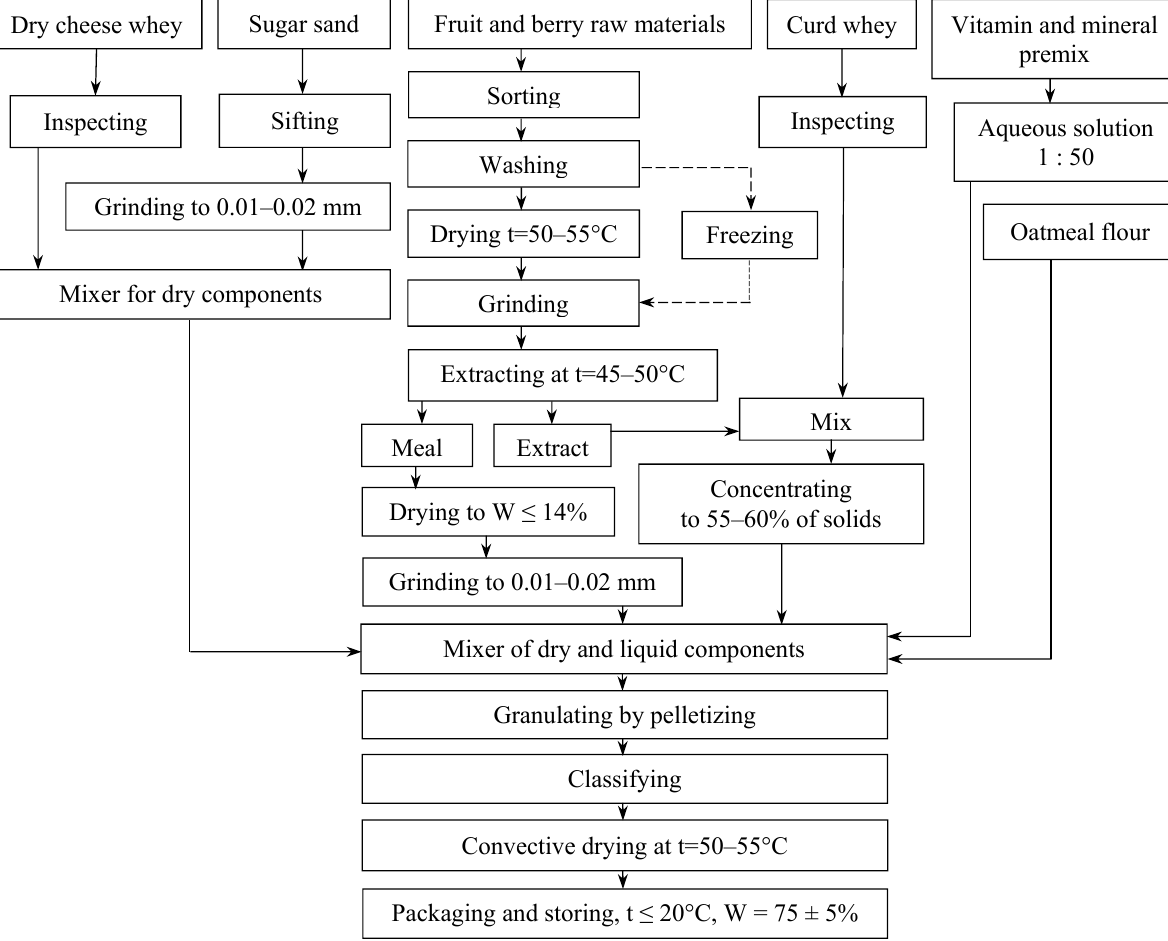
Fig. 6. Technological scheme of production of instant granular breakfast from whey and a chokeberry